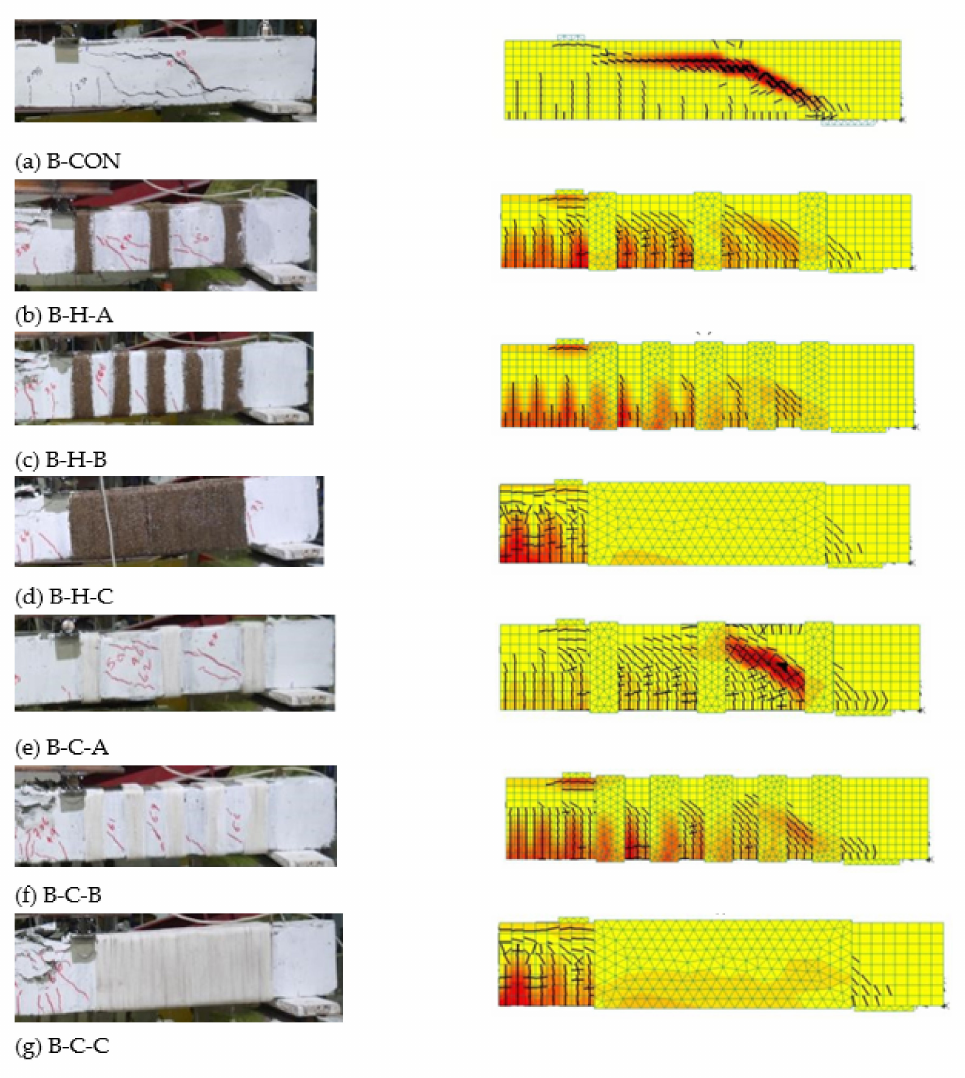
Figure 22. Comparison of finite element analysis cracking patterns versus experimental cracking patterns ( a ) B-CON, ( b ) B-H-A, ( c ) B-H-B, ( d ) B-H-C, ( e ) B-C-A, ( f ) B-C-B, ( g )